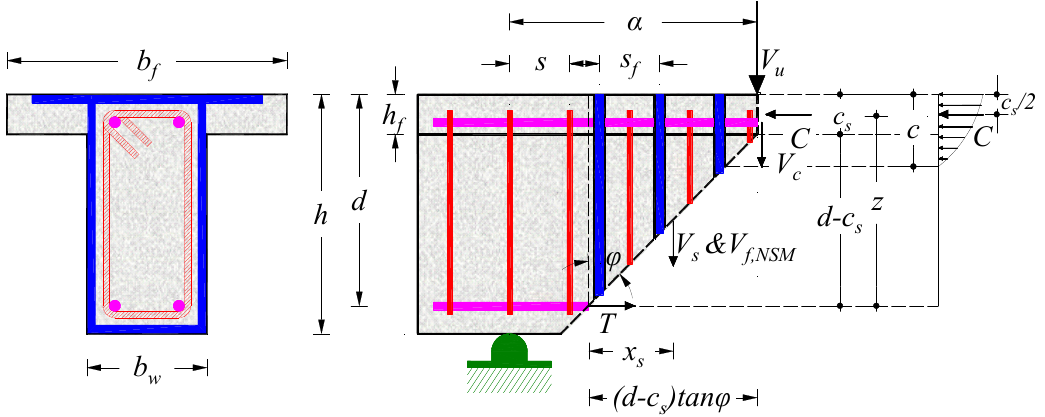
Figure 10. Shear transfer mechanisms in a characteristic RC deep beam with T-shaped cross-section, steel bars and stirrups, which has been strengthened in shear using FRP ropes as transverse link reinforcement using the near surface-mounted (NSM) system.